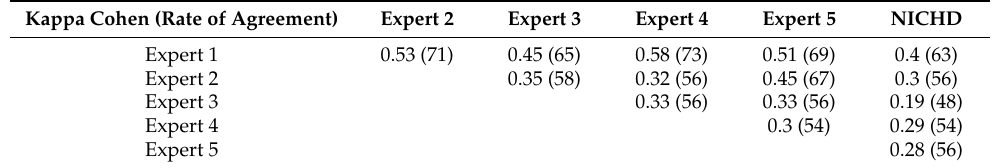
Table 3. Inter-observer concordance study between committee experts and National Institute for Child Health and Human Development (NICHD). NICHD classify the late-onset bacterial sepsis (LOS) in three groups as the expert did. Kappa Cohen (Rate of